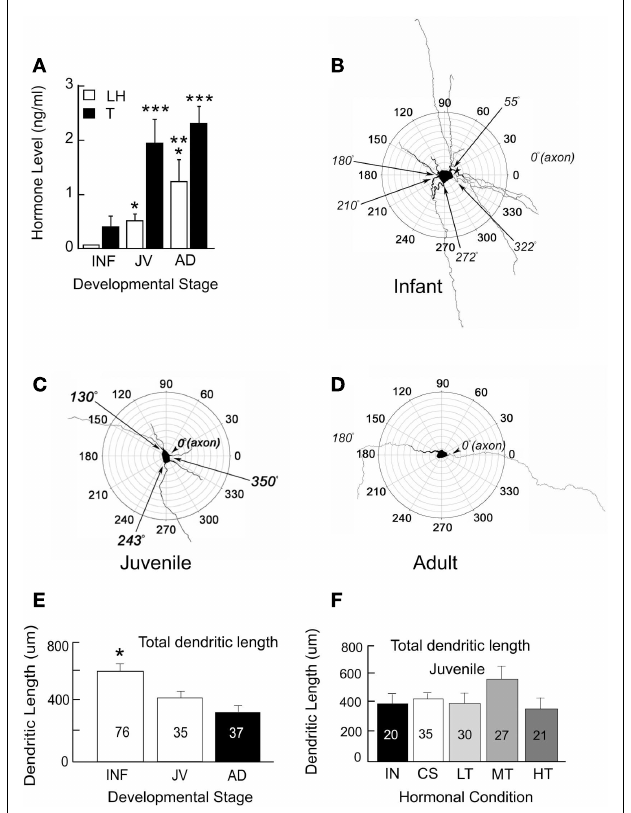
FIGURE 1 | Circulating levels of hormones (A) and polar plots of GnRH neurons from infant (INF, B), juvenile (JV, C), and adult (AD, D) male rats . Single asterisks indicate LH levels that are significantly higher than those in INF. Double asterisks indicate LH levels that are higher than those in INF and JV.Triple asterisks indicateT levels that are higher than those in INF. Multiple primary dendrites emerge from GnRH somata during infancy. A majority of these dendrites are no longer present in juveniles and adults. Total dendritic length decreases throughout sexual maturation (E) but does not appear to depend on levels ofT (F) . Males at about 43days of age have the same total dendritic lengths whether they have testes (INT), were castrated (CS), or castrated and treated with low (LT), medium (MT), or high levels (HT) ofT. Numbers of neurons are indicated on each bar. Figure is used fromYbarra et al. (2011). Copyright 2011,The Endocrine Society .